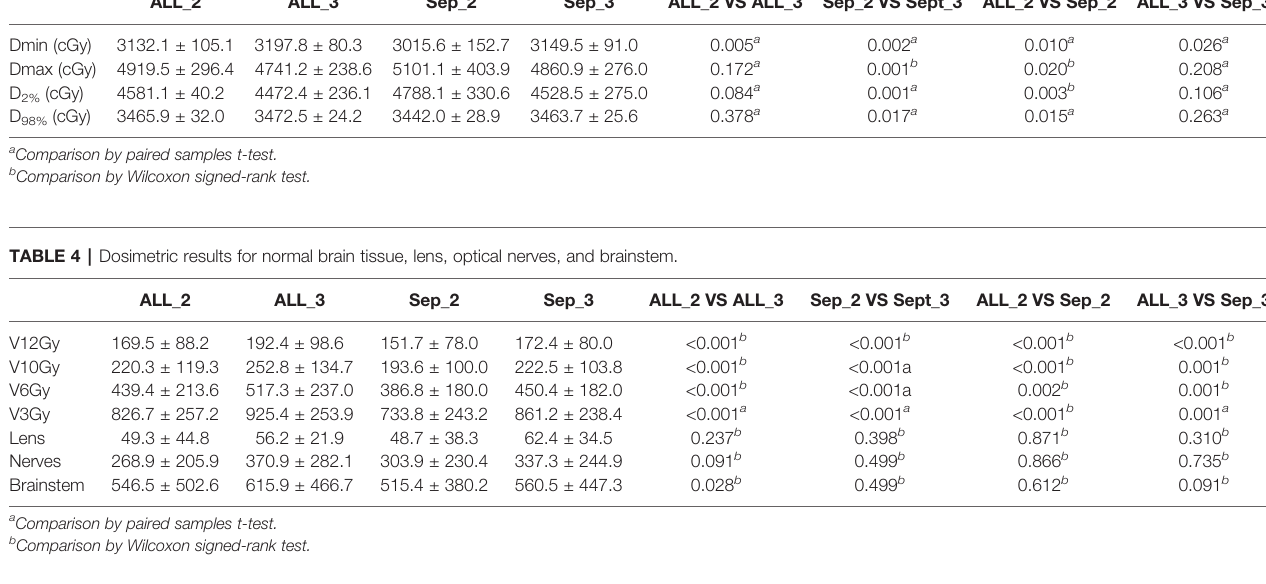
TABLE 5 | Dosimetric results for plan quality.